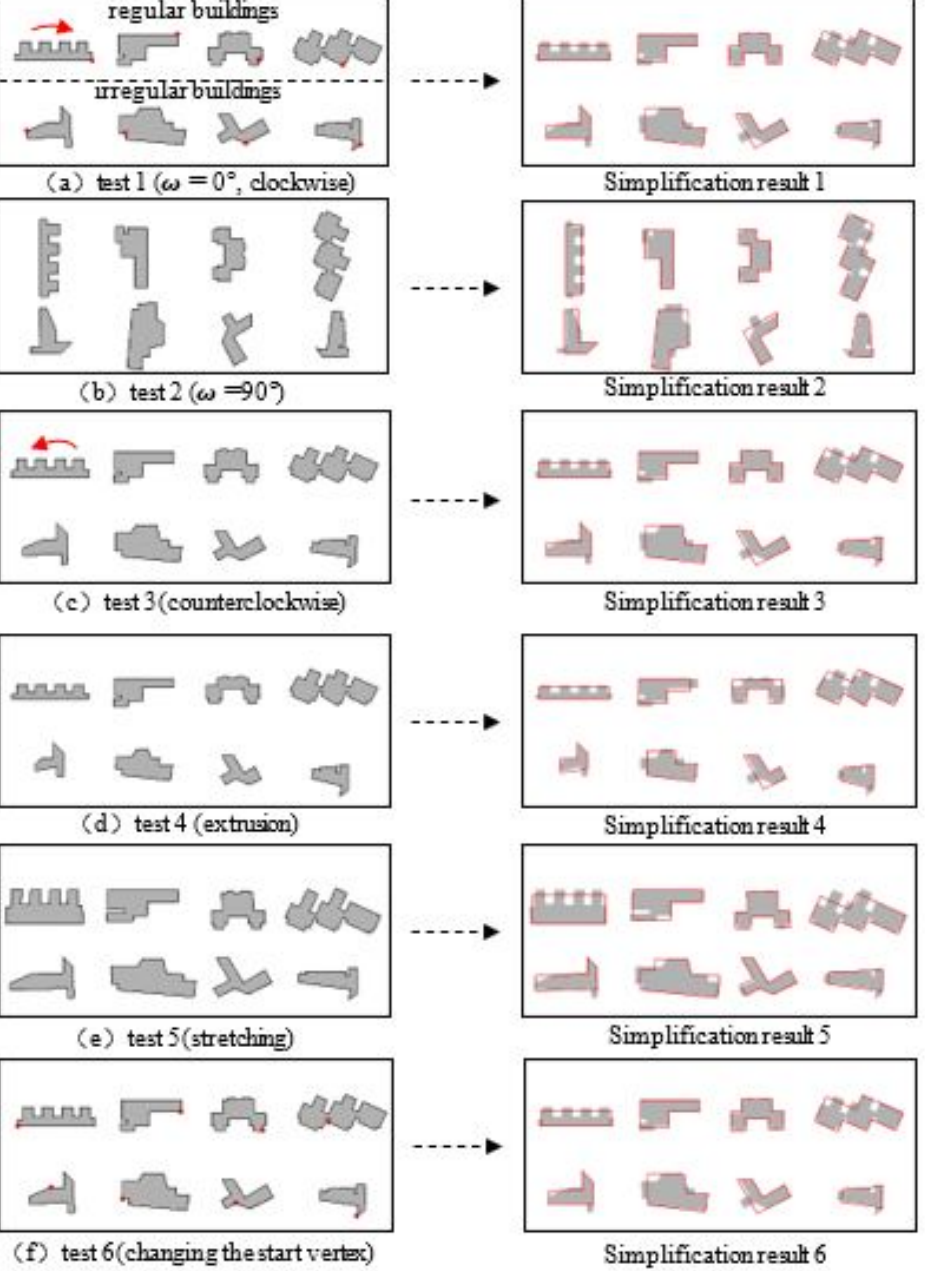
Figure 15. Tests of building simplification. ( a ) is the original buildings and simplified result; ( b ) is the test of directional dependence; ( c ) is the test of changing vertices sequence as counterclockwise; ( d , e ) is the test of extrusion and stretching; ( f ) is the test of adjusting the start vertex.